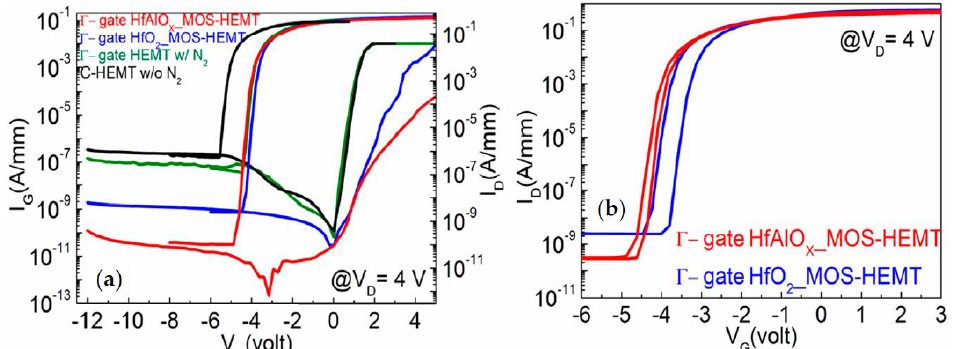
Figure 6. Comparison of ( a ) subthreshold (@ V D = 4 V) and gate leakage (I G –V G ) characteristics of Γ -gate HEMT and Γ -gate HfO 2 and HfAlO X MOS-HEMT with the N 2 plasma treatment and non-recessed HEMT (w/o the N 2 plasma treatment). ( b ) Hysteresis characteristics of (@V D = 4 V) Γ -gate HfO 2 and HfAlO X MOS-HEMT with the N 2 plasma